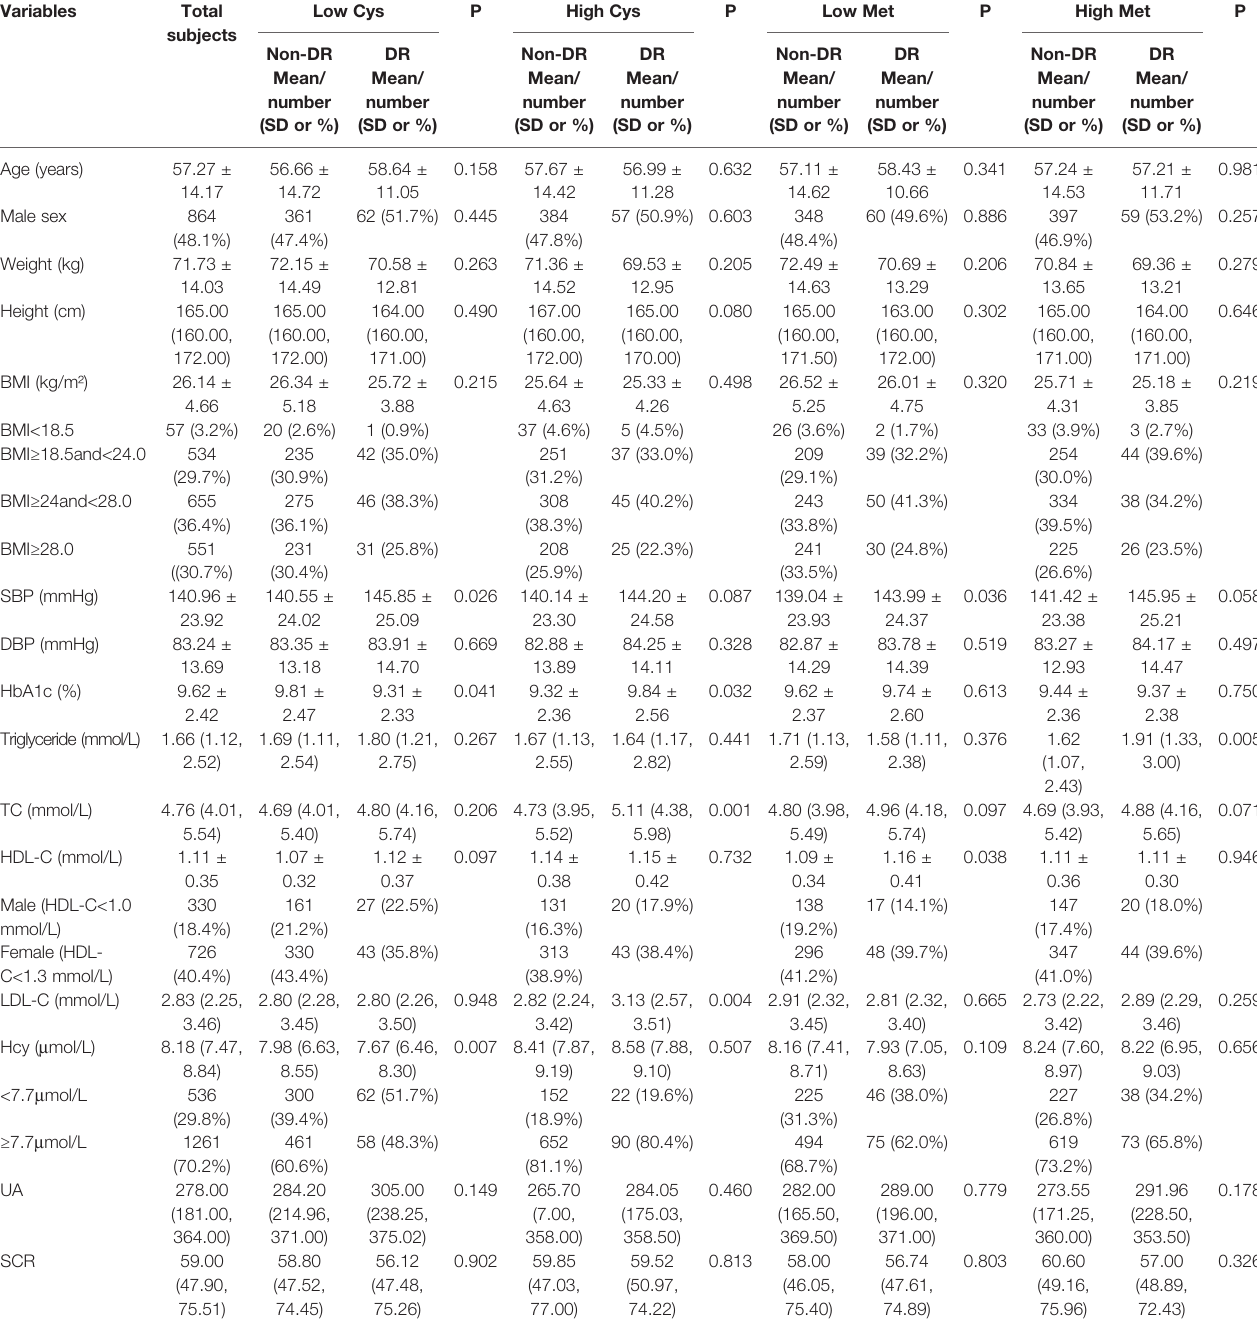
TABLE 1 | Clinical and biochemical characteristics of participants according to the occurrence of diabetic retinopathy.